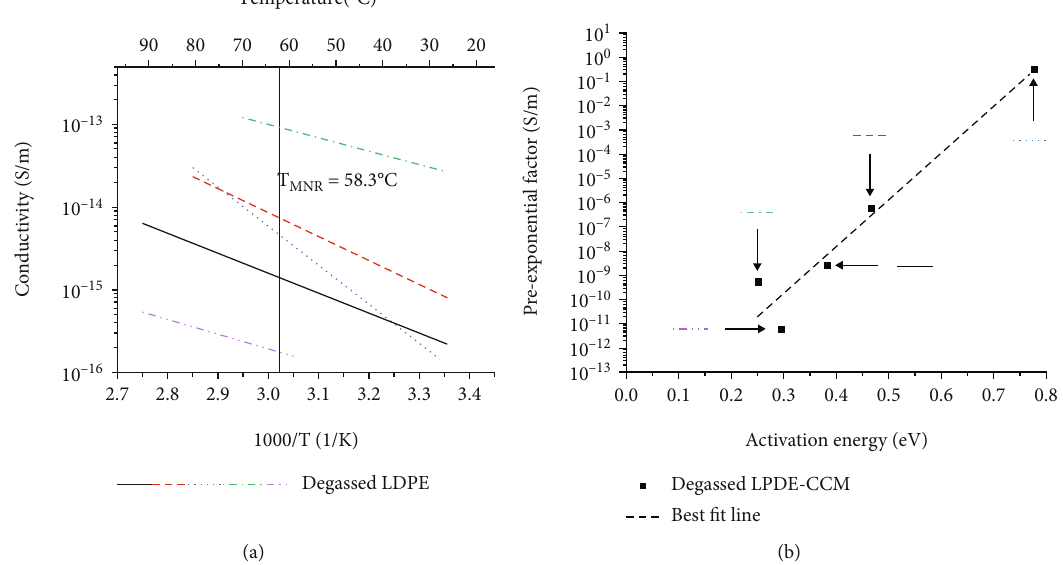
Figure 2: (a) Conductivity vs. temperature plot and (b) compensation law plot for degassed LDPE samples. All samples melt pressed at 180 ° C for 12 minutes. Degassing done in a vacuum oven at 65 ° C for 72